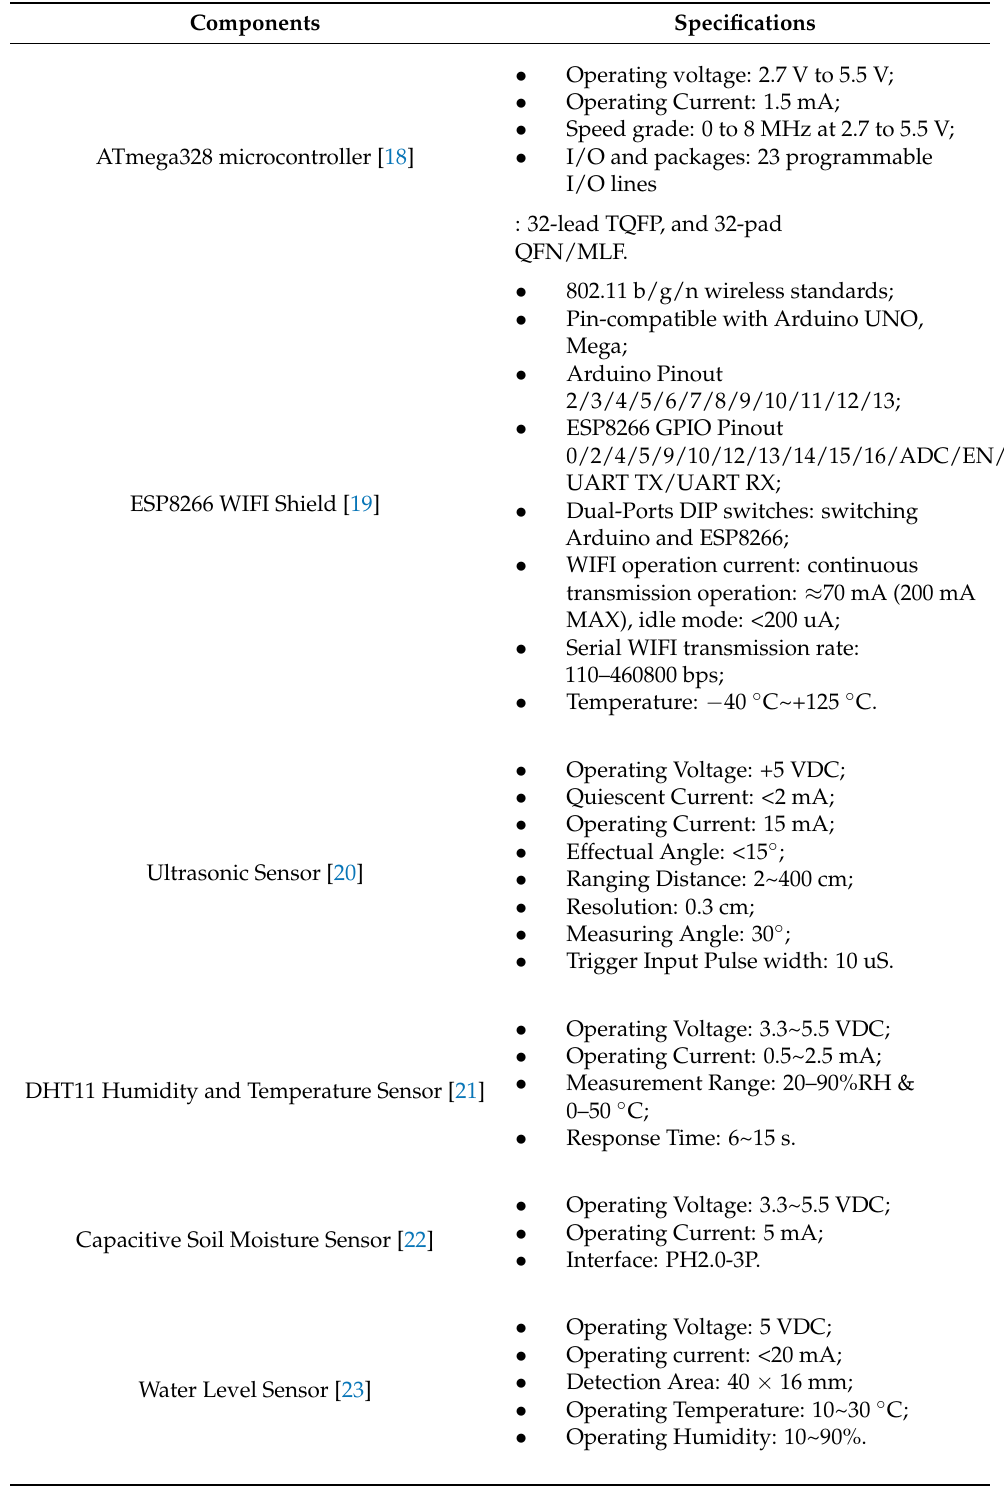
Table 1. Specifications of the